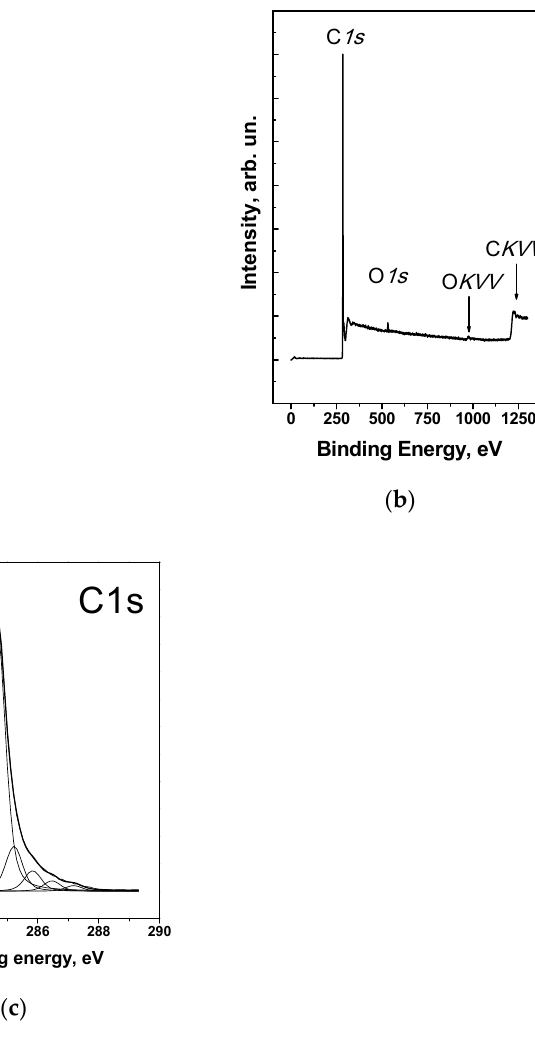
Figure 4. Raman spectrum ( λ = 514 nm) ( a ); survey XPS spectrum ( b ); C1s spectrum of CNF mate- rial ( c ) Reproduced with permission of Elsevier [49]. ( c ) Reproduced with permission of Elsevier